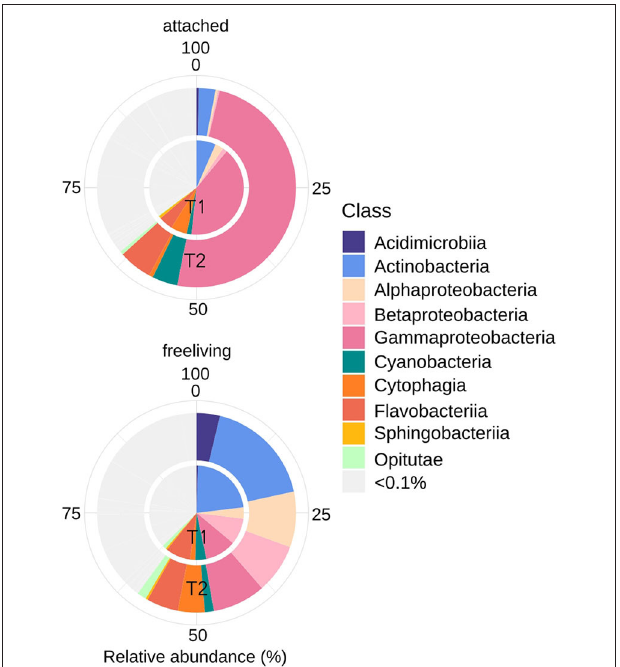
FIGURE 3 | Bacterial community composition (16S rRNA) including ASVs with an average (of triplicates) relative abundance > 0.1% per timepoint (T1 or T2). Assigned taxonomy at class